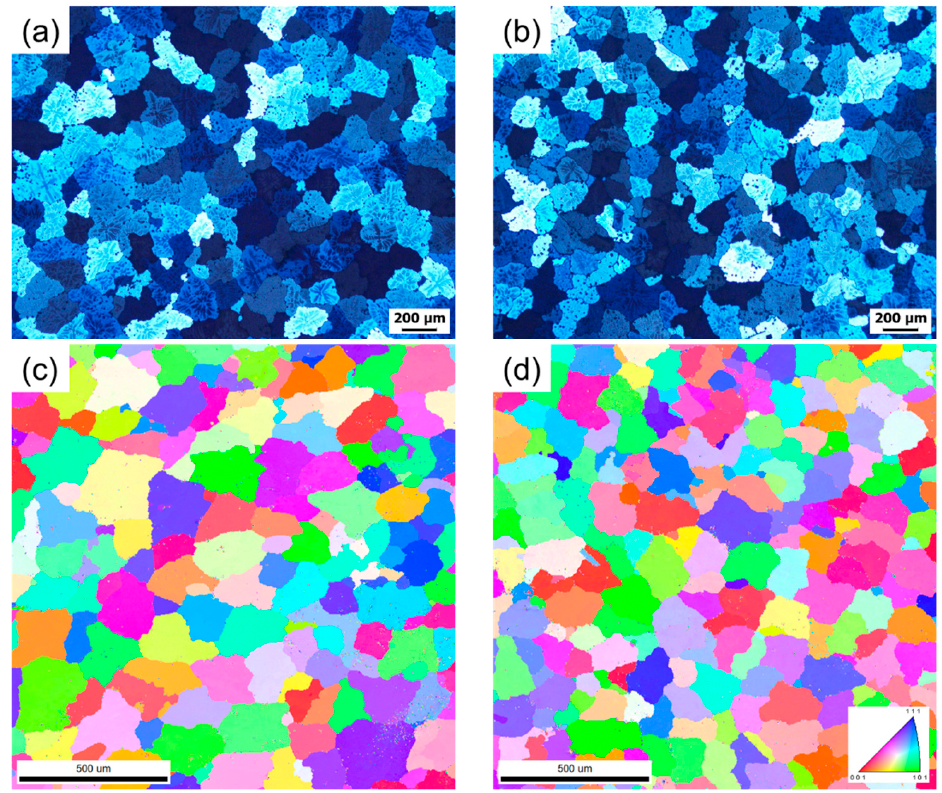
Figure 3. Grain structure of homogenized initial microstructure for ( a ) Al-6Mg, ( b ) Al-8Mg by an optical microscope, and ( c )Al-6Mg, and ( d )Al-8Mg by an EBSD IPF map.